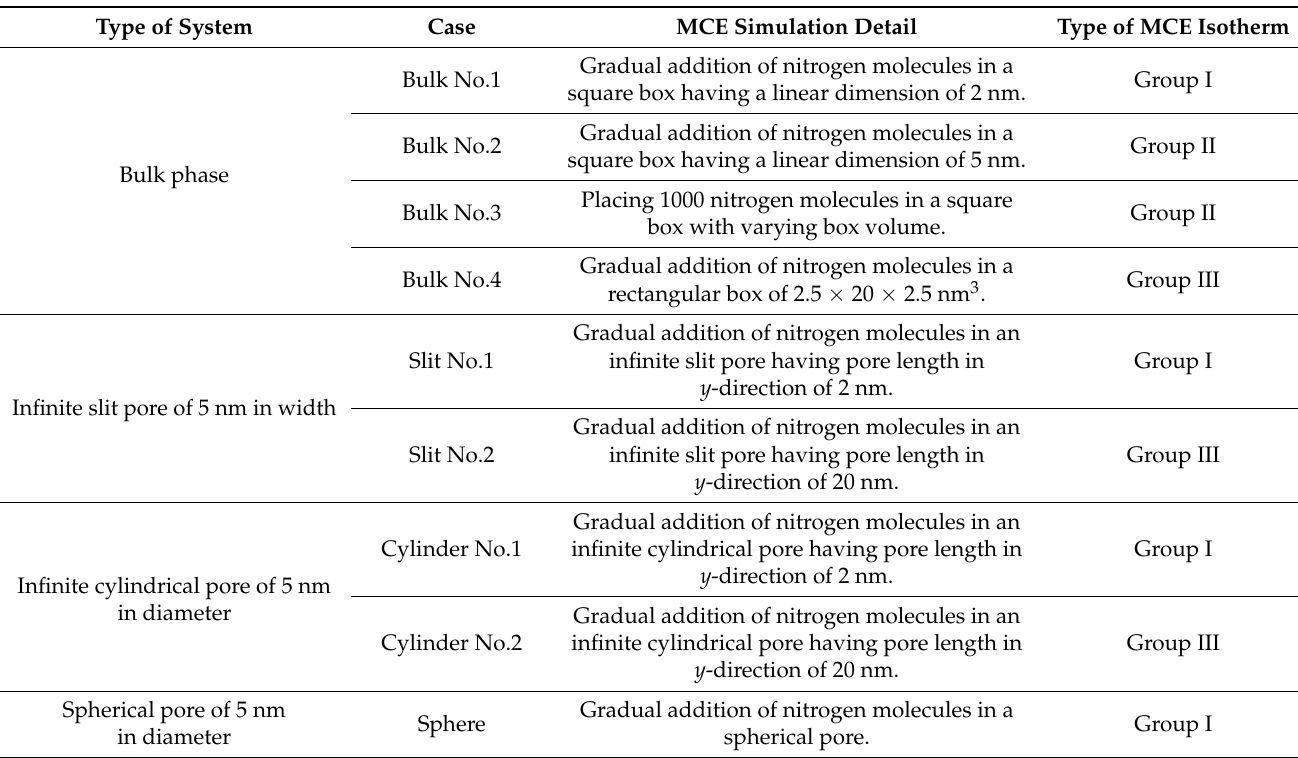
Table 1. Explanations of different cases for the bulk-phase and pore systems to be modelled by MCE